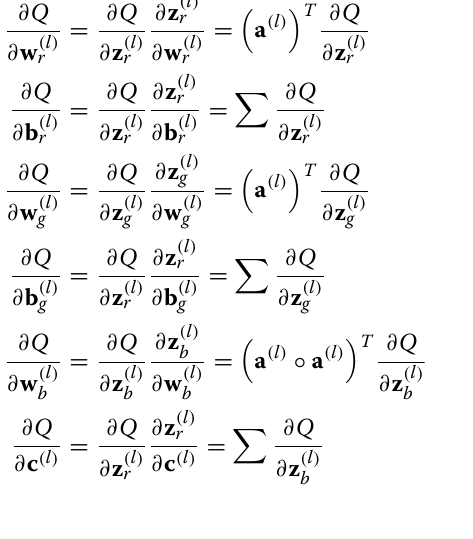
weight = 0.01 · np . random . randn ( d _ from , d _ to ) bias = np . zeros ( [ 1 , d _ to ]